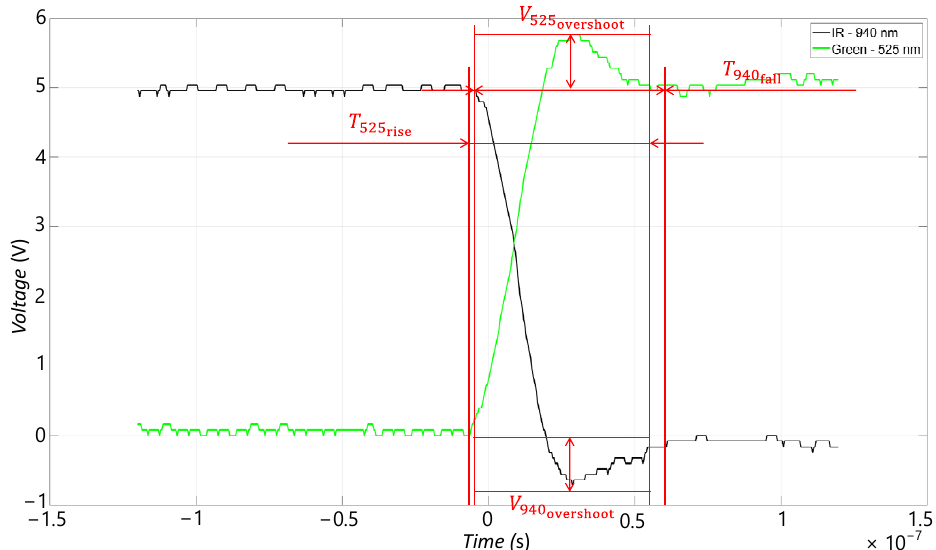
Figure 14. Recorded transients when the LEDs with a wavelength of 940 nm were switched on and the LEDs with a wavelength of 525 nm were switched off.